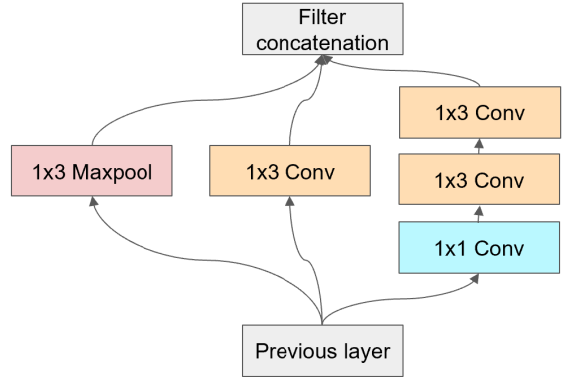
Figure 4. Convolutional neural network of layer 2.